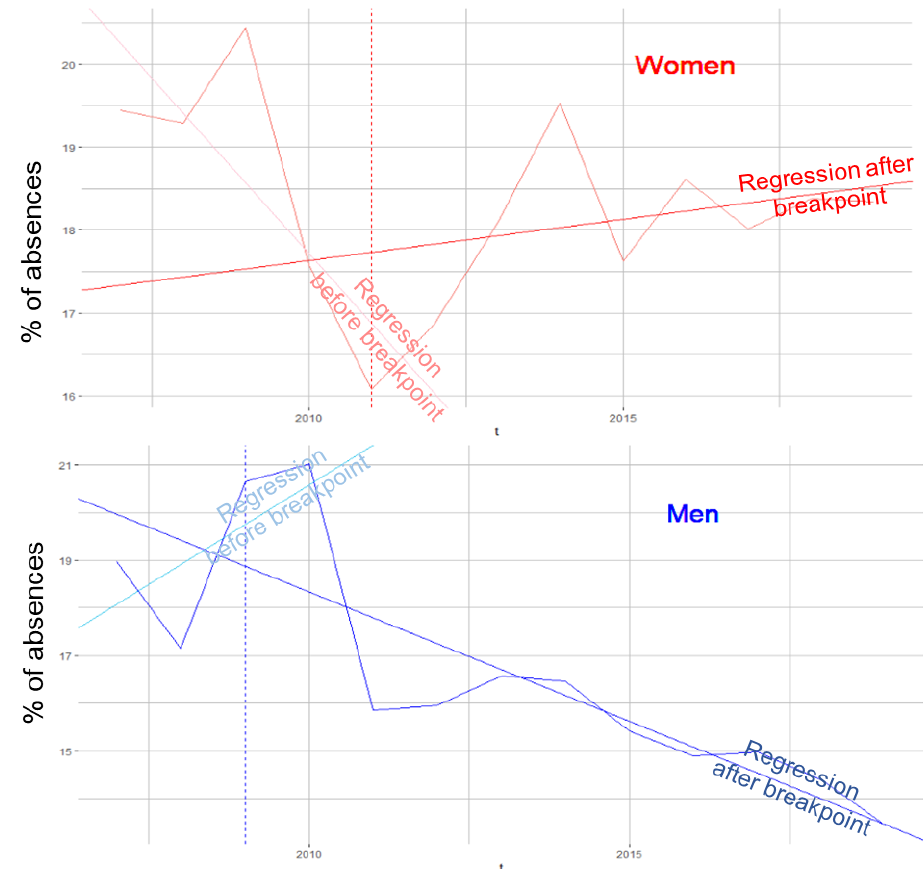
Figure 3. Proportion of annual absences by gender with linear trends and break points.